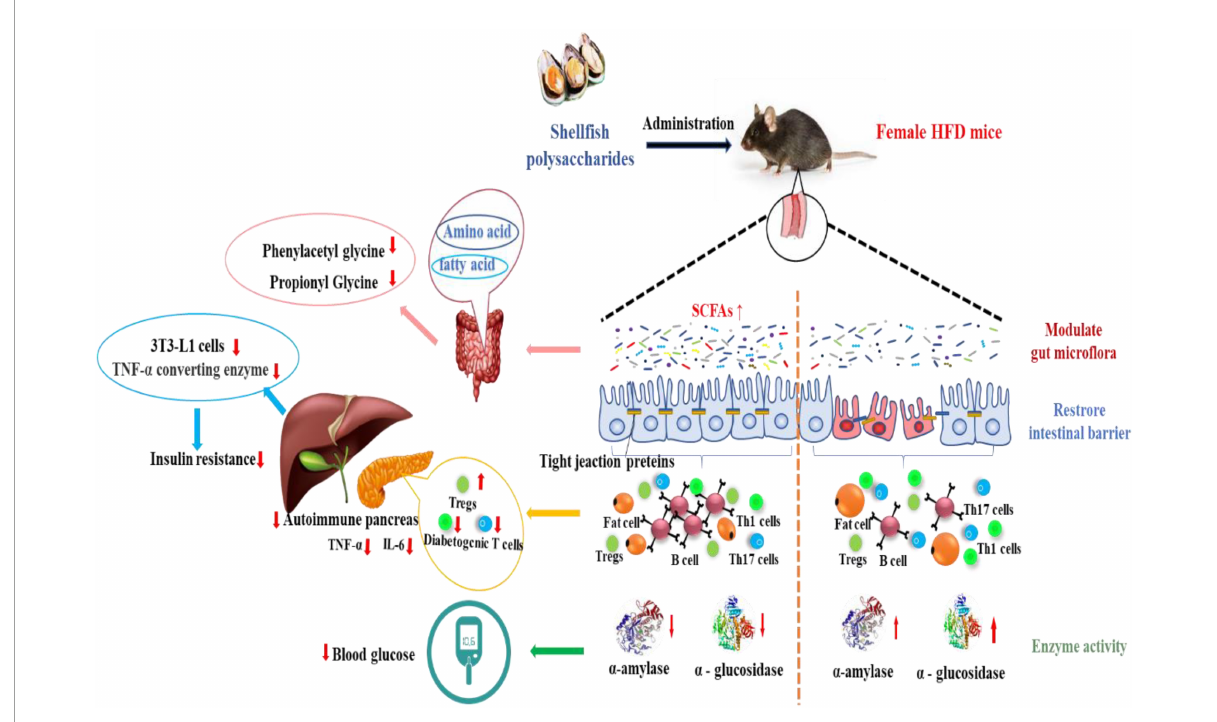
FIGURE5 Shellfish polysaccharides reduce hyperglycemia